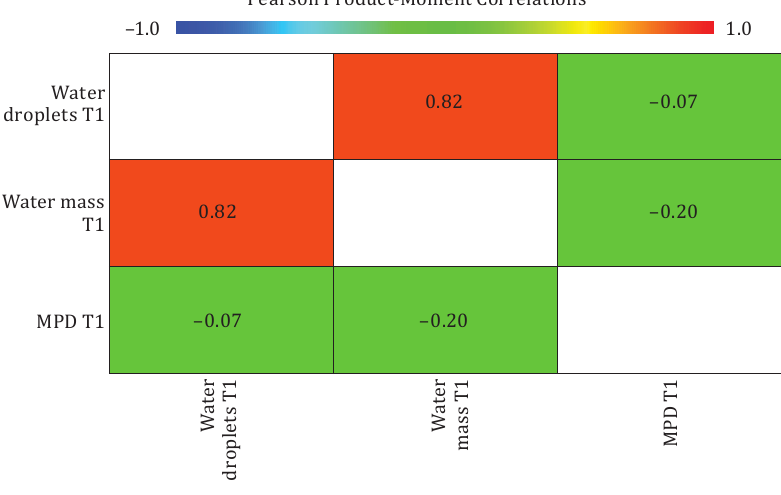
Figure 14. Pearson product-moment correlations between each pair of variables for Test Track 1